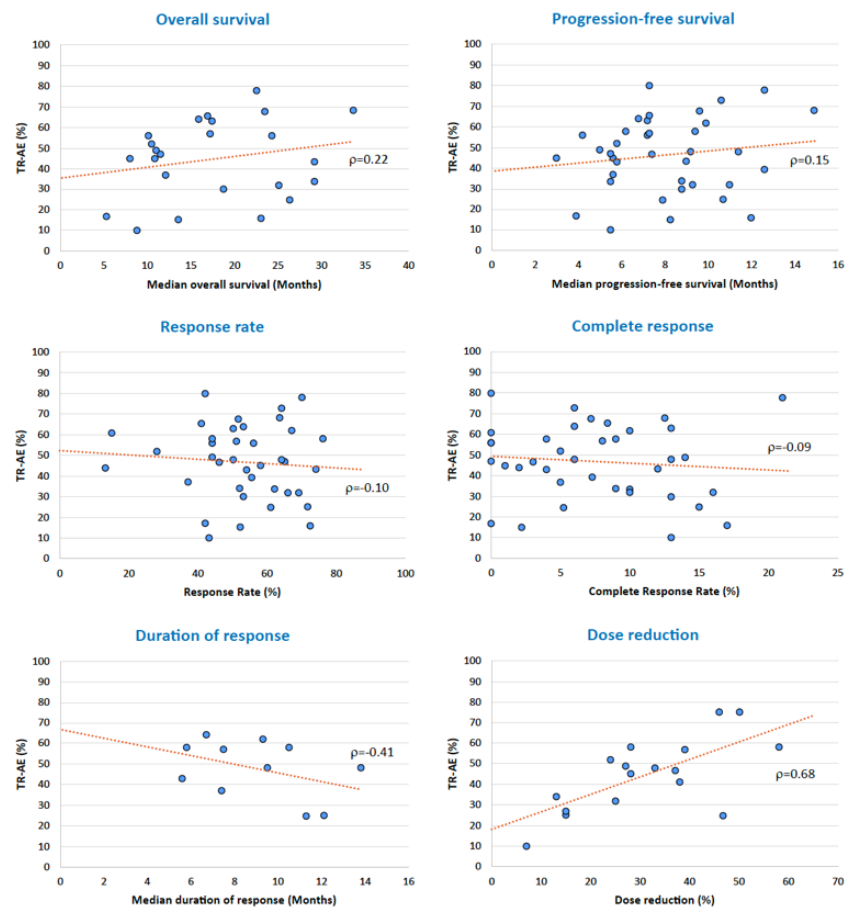
Figure 7. Correlation between incidence of all-grade adverse events and oncological outcomes.